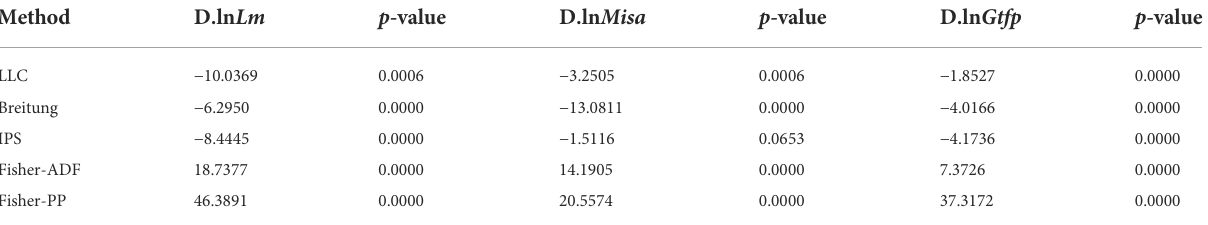
TABLE 2 Stationary test of the main variables.